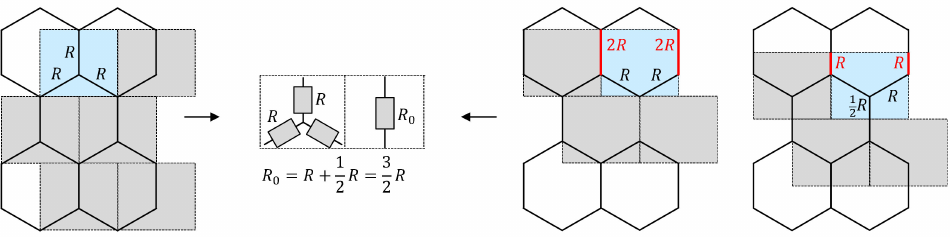
Figure A1. Various possible unit cells of the tubular hexagonal mesh are shown as shaded rectangles. The total resistance R 0 in each unit cell is the same.